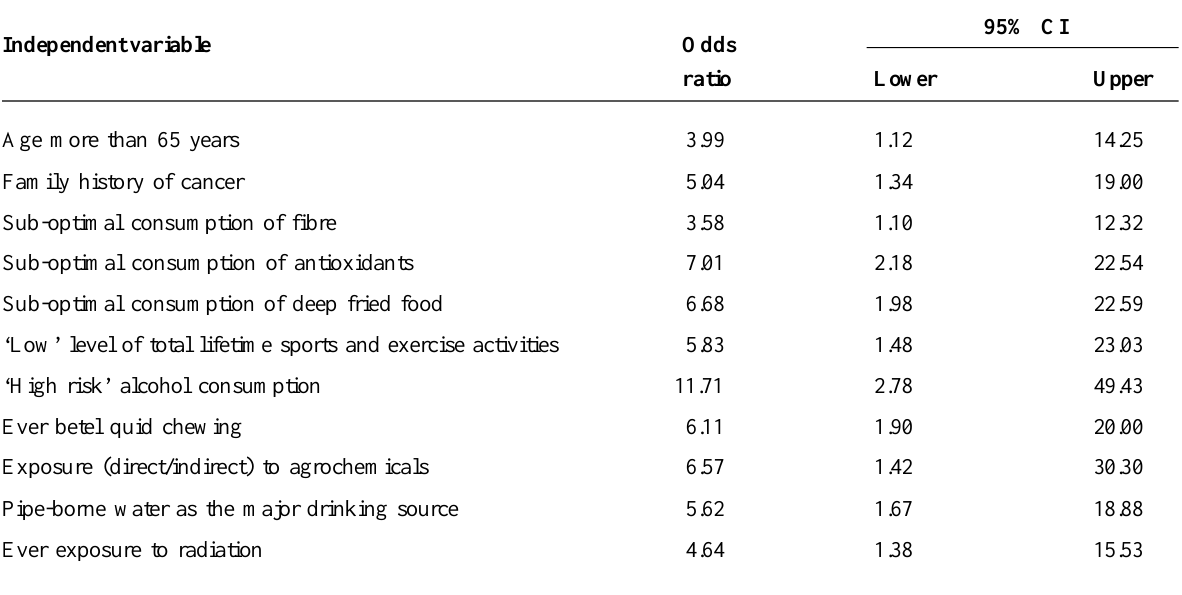
Table 1. Risk factor profile of oesophageal